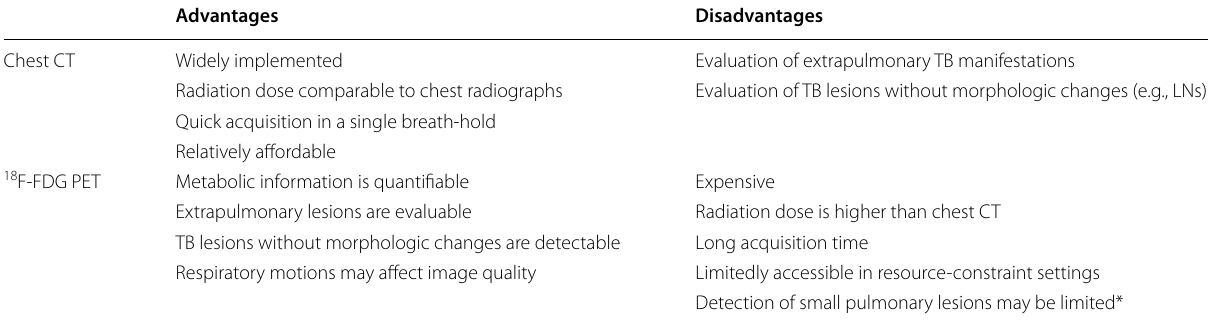
TB —tuberculosis; CT —computed tomography; 18 F-FDG —18-fluorodeoxyglucose; PET —positron emission tomography; MR —magnetic resonance; LN— lymph node *Detection of small pulmonary lesions may be limited on a PET/MR